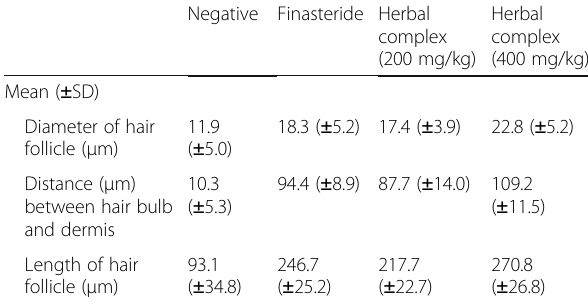
Table 1 Effect of the herbal complex: histologic findings at day 25 Negative Finasteride Herbal